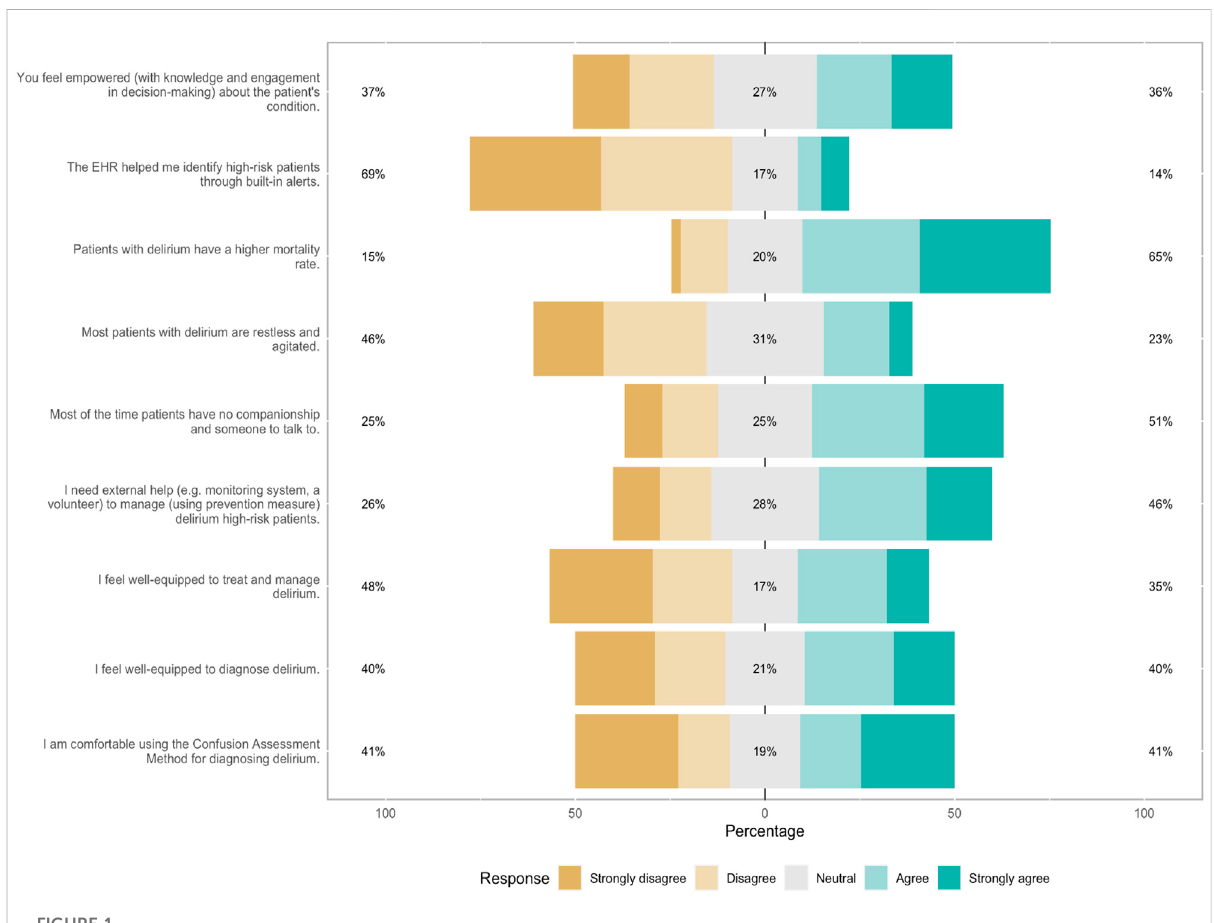
FIGURE 1 Likert scale of healthcare professionals of delirium current practices and